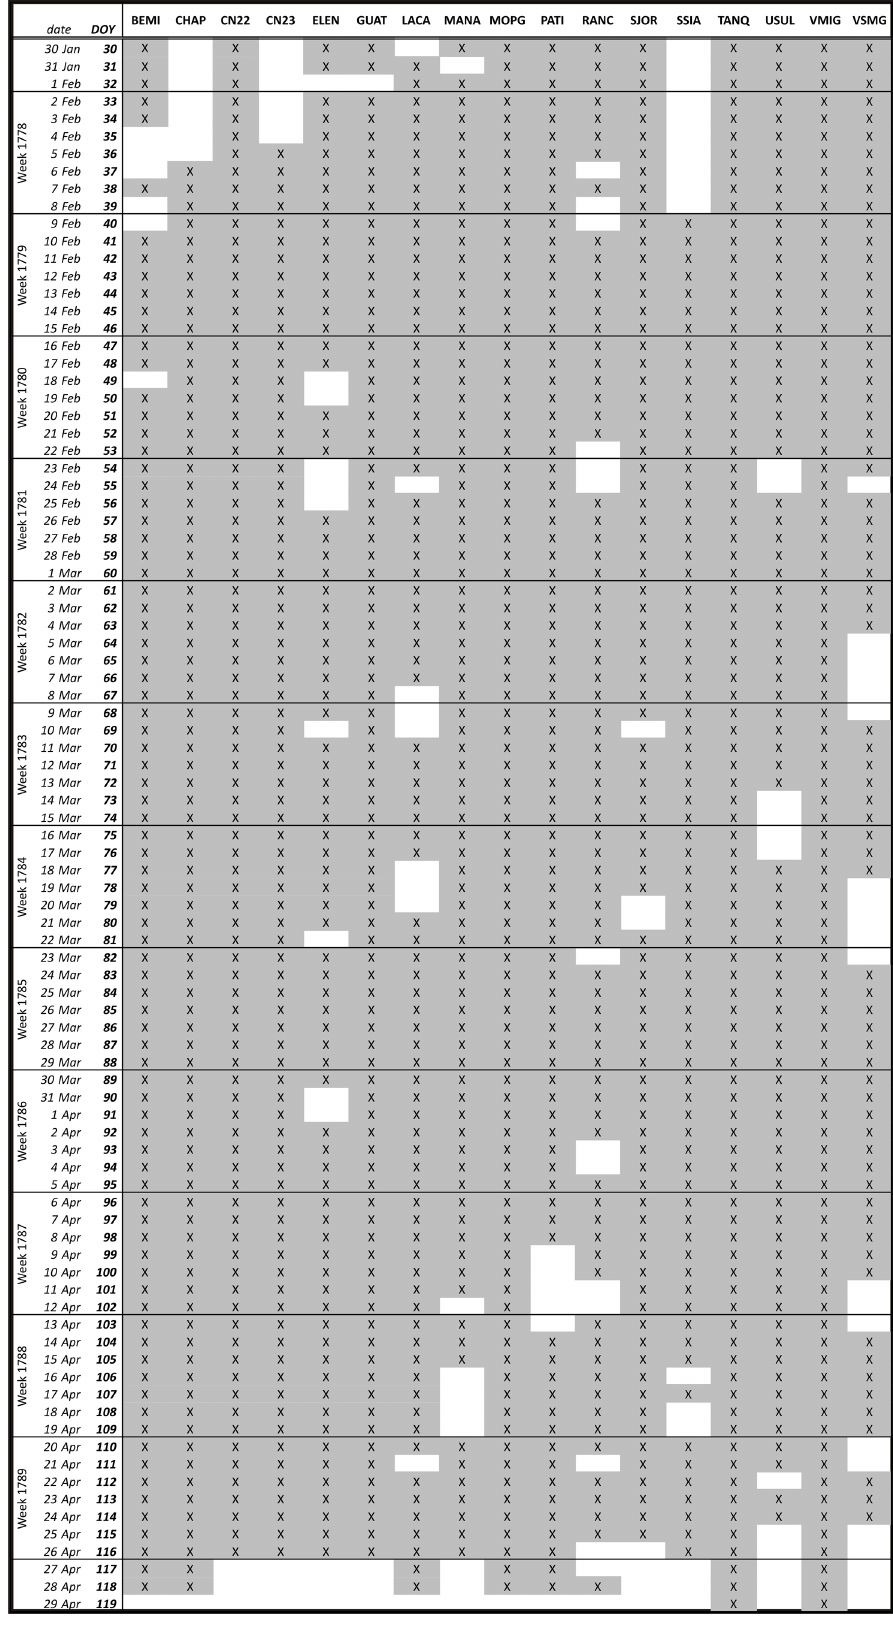
Figure 7. Continuity of data acquisition at the GPS stations used for the weekly